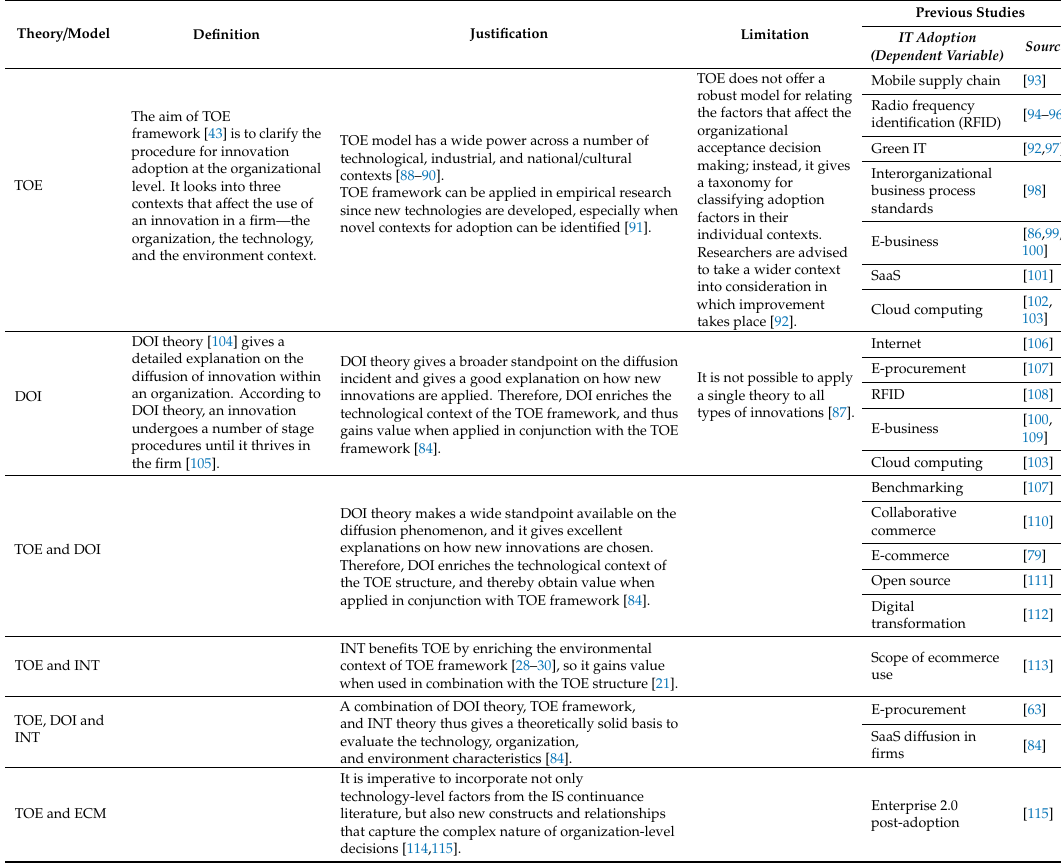
Table 2. Mapping matrix of the model